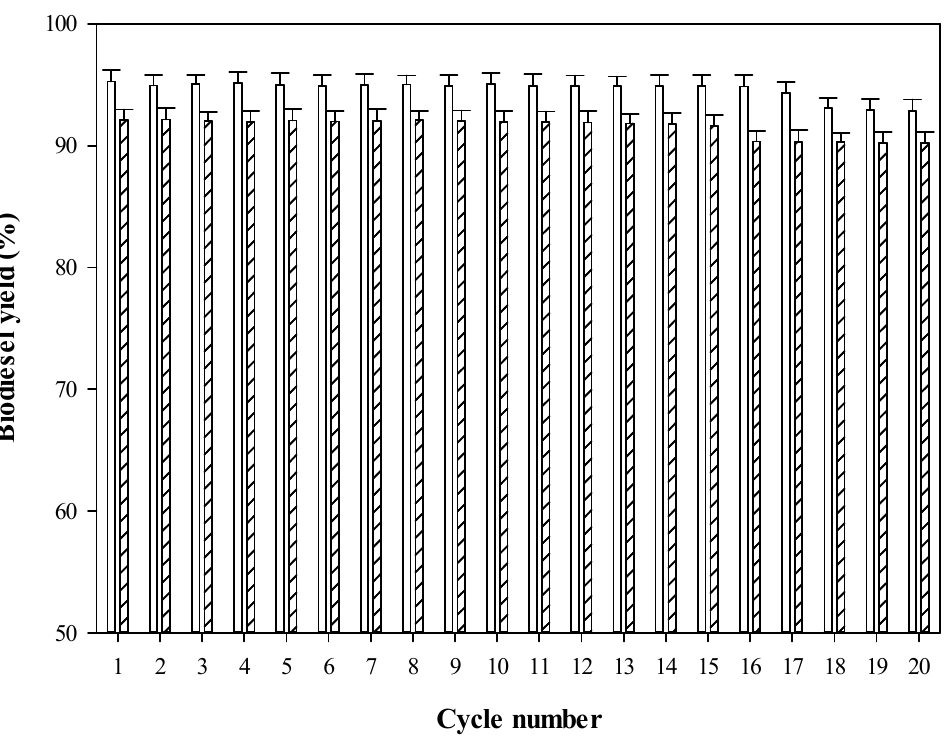
Figure 4. Biodiesel yield (%) as a function of cycle number for testing reusability and stability of immobilized lipase during esterification reaction (CPO biodiesel yield RPO biodiesel yield). Table 3. Comparative biodiesel yield obtained from CPO and RPO via different processes. Raw Material